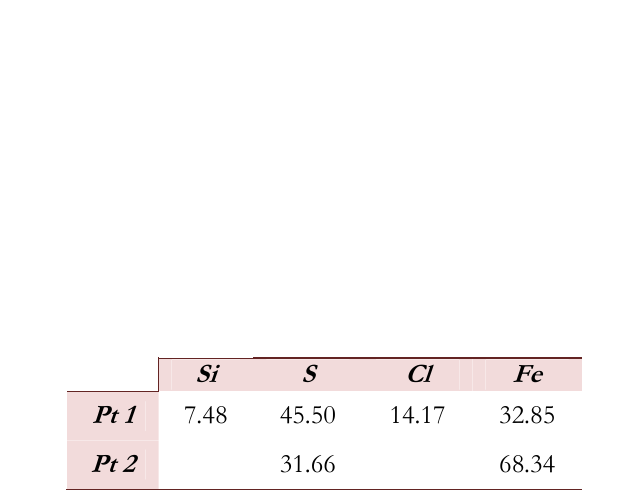
Table 4: EDS analysis (weight%) of areas shown in the Fig.